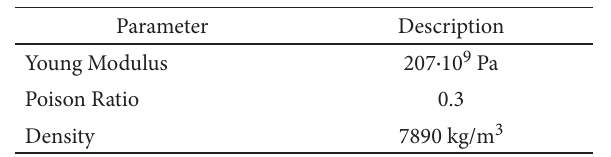
Table 1. Mechanical parameters of steel